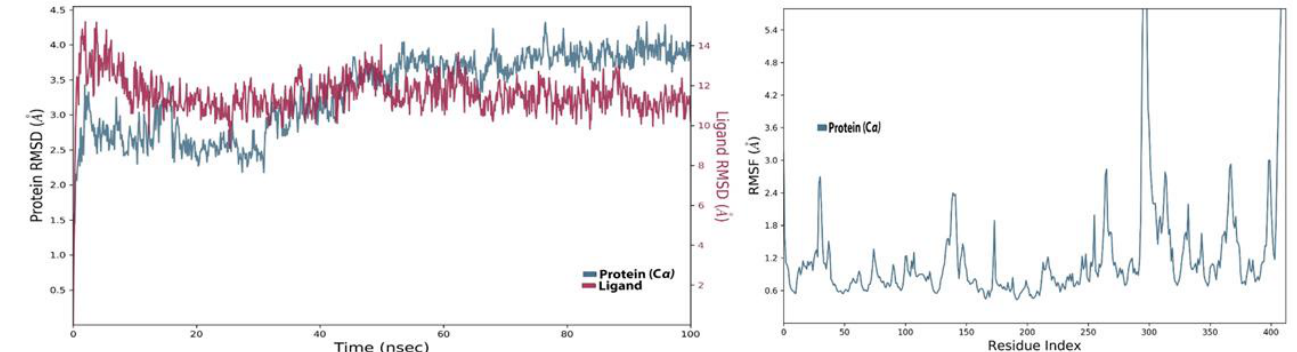
Figure 12. RMSD and RMSF of SARS-CoV-2 NSP10/NSP16 MTase and ZINC000009464451 complex.